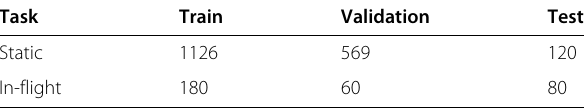
Table 2 Audio data points created from SP Cup 2019 data Task Train Validation Test Static 1126 569 120 In-flight 180 60